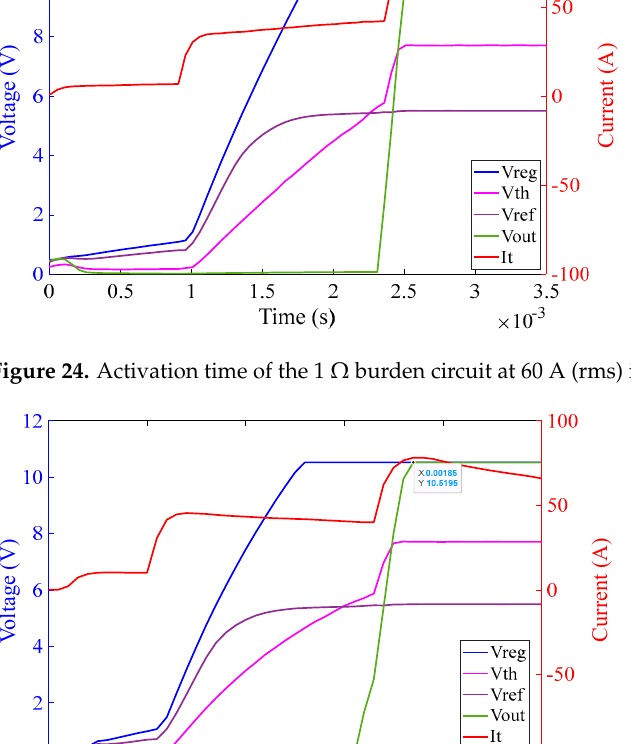
Figure 25. Activation time of the 1 Ω burden circuit at 60 A(rms) input current with 90° phase angle.